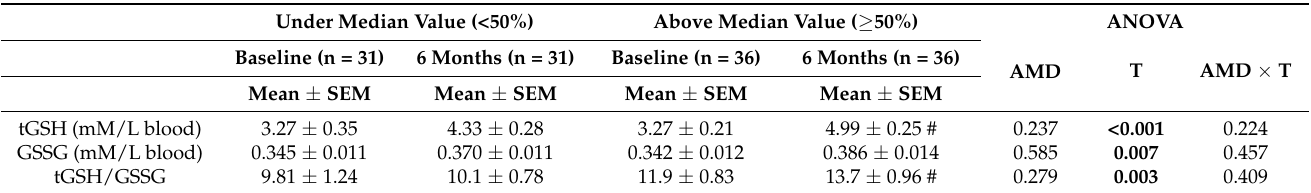
Table 6. Glutathione determination in blood of participants “Baseline” and “6 months” stratified by adherence to Mediterranean diet (AMD).